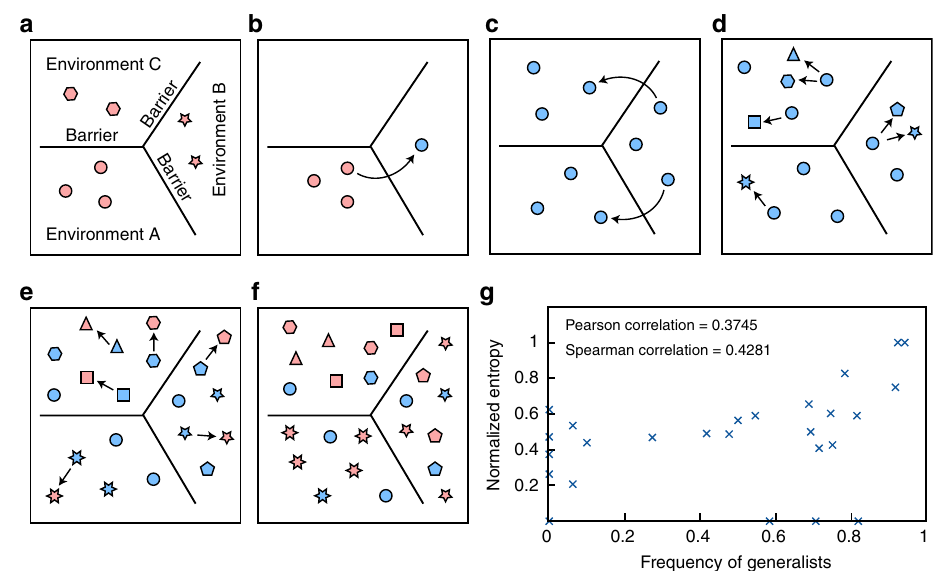
Fig. 4 The model of microbial dispersion and evolution driven by generalist species. Generalists and specialists are represented in blue and red, respectively. Each shape represents a species. a Habitat occupancy of specialists is limited by environmental barriers. b A new generalist seldom emerges from a specialist lineage. c Descendants of the new generalist lineage expand into new environments. d Each environment separately drives the evolution of each descendant. e Eventually, some descendants begin to specialize to their new habitats. f This cycle of transformations effectively introduces a large number of new species across multiple environments. g Scatterplot between the frequency of generalist species and the normalized entropy of the distribution of specialist species among 11 environmental clusters. Each data point corresponds to one of the partition of the archaeal-bacterial phylogenetic tree (Methods). High normalized entropy means that specialist species in that cluster belong to diverse